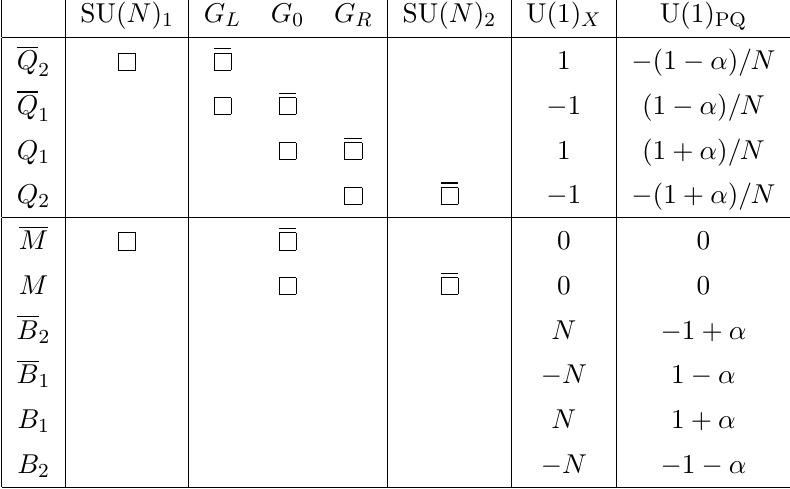
G 0 G R and the global (cid:2) (cid:2)